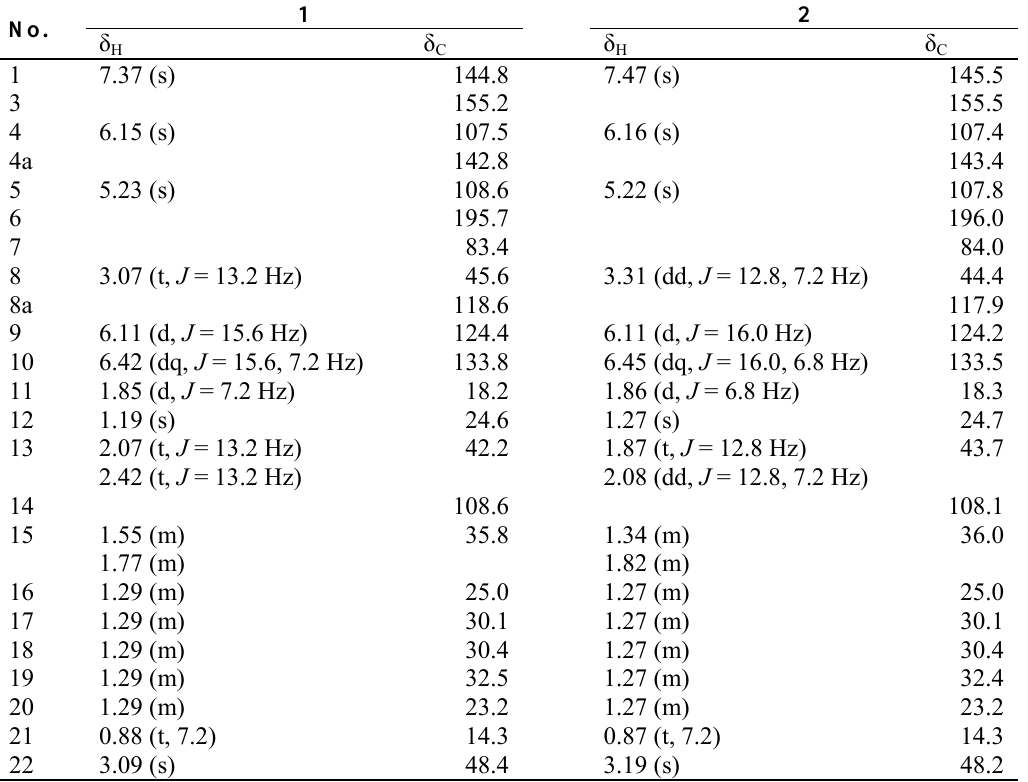
Table 1. 1 H-NMR (400 MHz) and 13 C-NMR (100 MHz) spectroscopic data